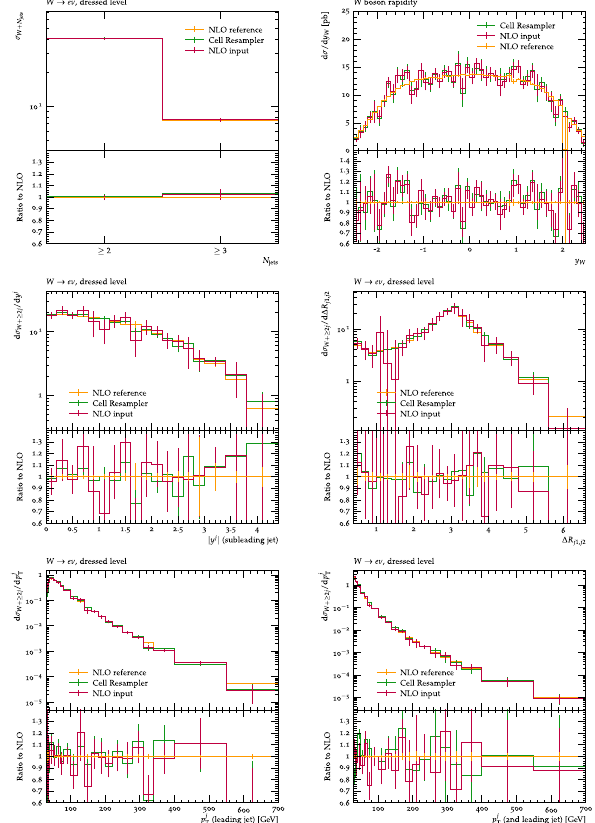
Fig. 6 The results from the pure NLO calculation and of resampler for a subset of the analyses performed. See text for further